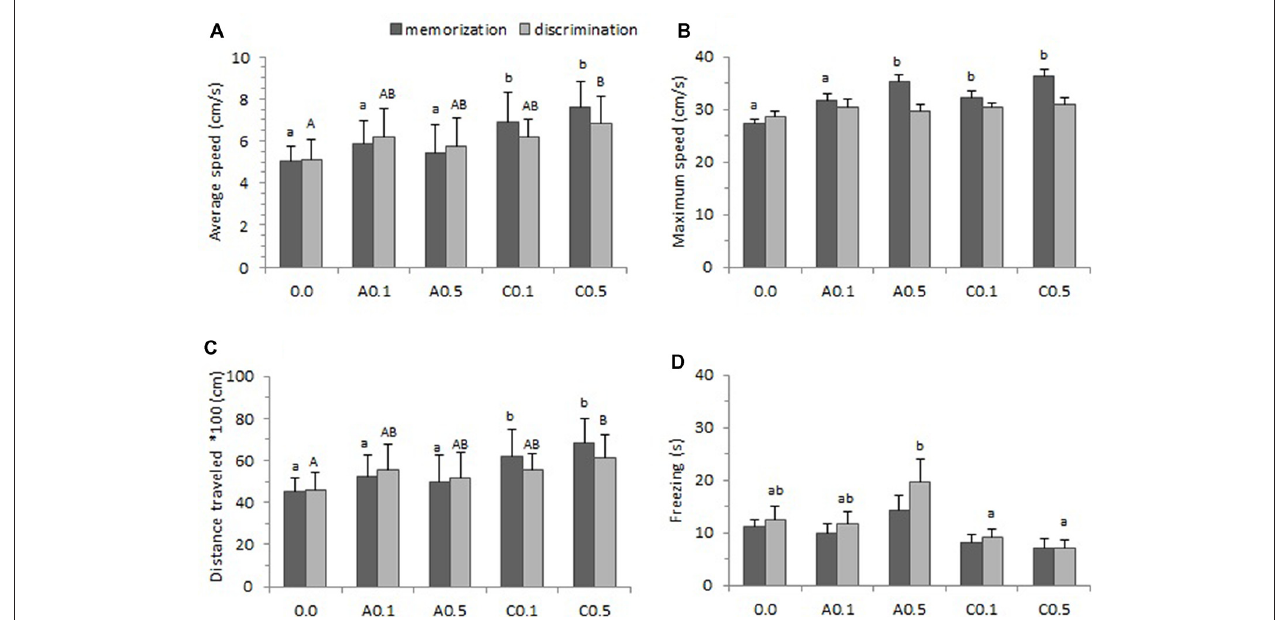
FIGURE 4 | Locomotor parameters observed during one-trial learning test. (A) Average speed, (B) Maximum speed, (C) Total distance traveled and (D) Freezing. Five groups of Ayahuasca exposure were tested: 0.0 ml/L (control: 0.0, n = 20), acute 0.1 ml/L (A0.1, n = 20), acute 0.5 ml/L (A0.5, n = 20), chronic 0.1 ml/L (C0.1, n = 20), and chronic 0.5 ml/L (C0.5, n = 20). Fish behavior was recorded during 15 min on the memorization phase and 15 min during the discrimination phase. One-way ANOVA was applied for comparisons between groups on the memorization and on the discrimination phase. At least one different letter or ∗ indicates statistical significance at p < 0.05. Lower case letters were used for the memorization phase and upper case letter for the discrimination phase. For details see “Results”